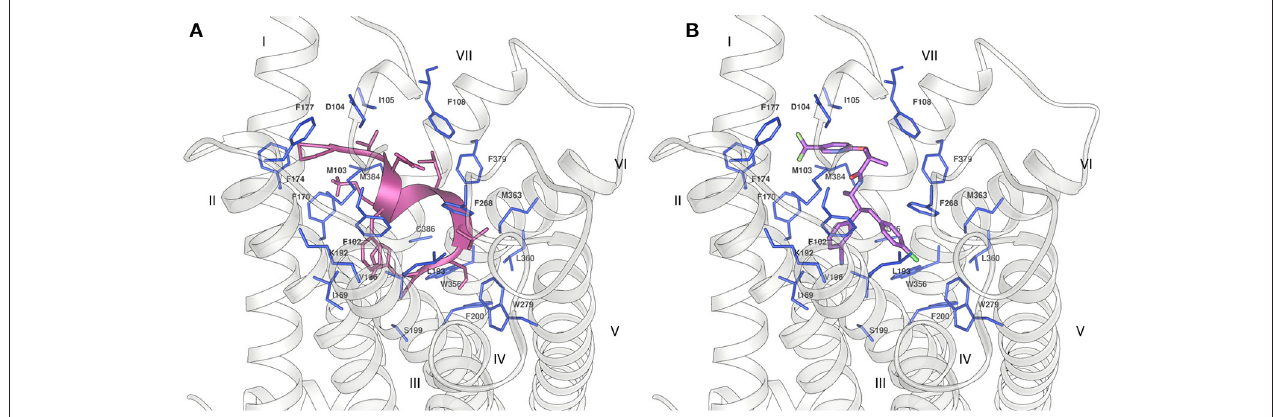
FIGURE 5 | Binding of (A) Pepcan-9 (pink) and (B) taranabant (purple) to the CB1 receptor (grey ribbon) (PDB code 5U09). The residues of the receptor in close proximity to the ligand are displayed as blue